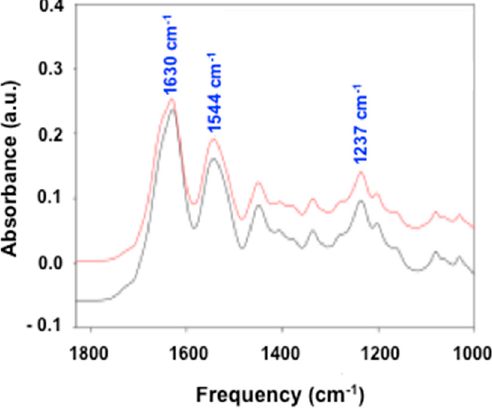
Figure 1. Composition of HEMOCOLLAGENE ® . Spectra obtained by Fourier transform infrared (FTIR) spectroscopy showing similarities of HEMOCOLLAGENE ® foam (red line) with type I collagen (black line). Table 1. Amino acid content assessed by ion exchange chromatography (residue numbers/1000).